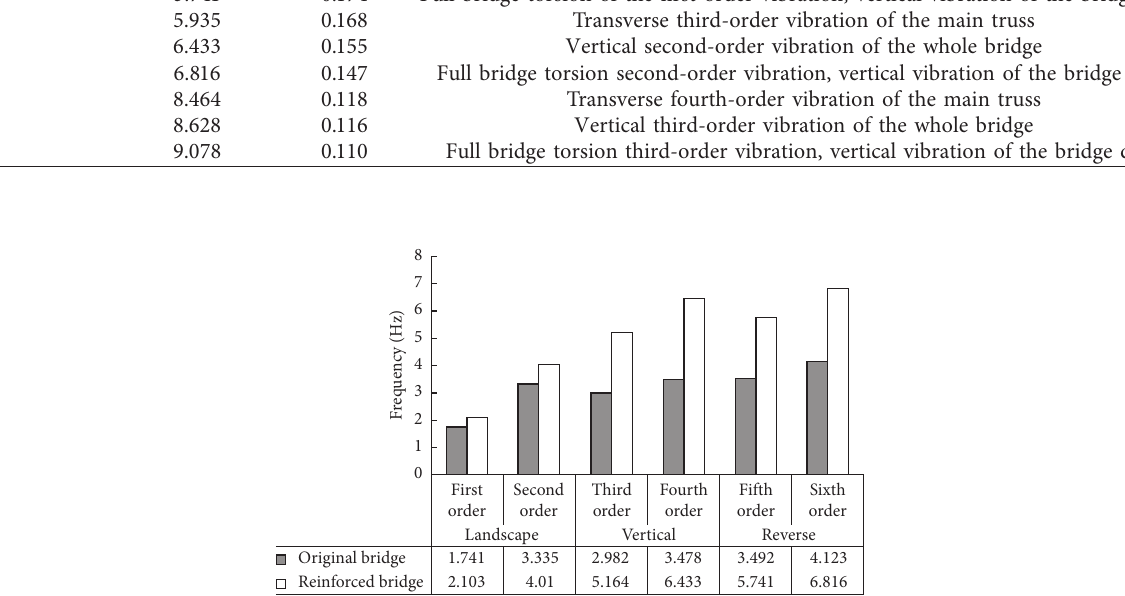
Figure 16: Comparison of the natural vibration frequencies of the bridge before and after